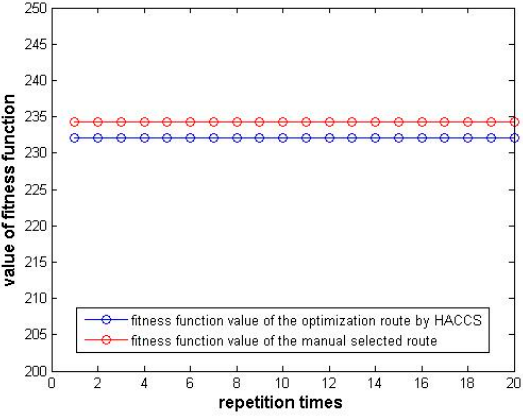
Figure 21. The final fitness function values with 20 repetitions of the HACCS.